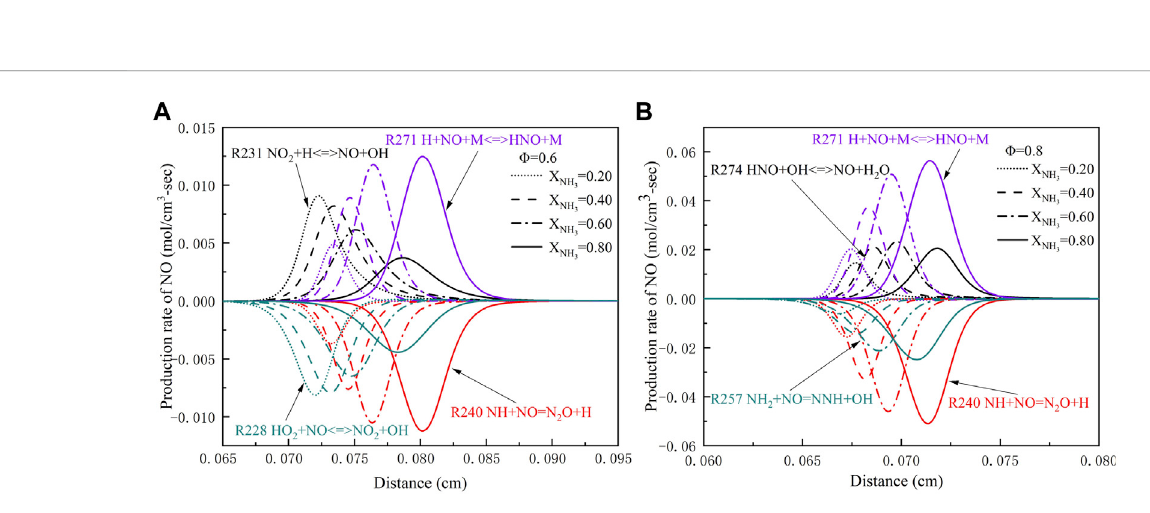
FIGURE 11 The production rate of NO with different ammonia content: (A) Φ = .6; (B) Φ = .8. (T = 723 K, p = 16.5